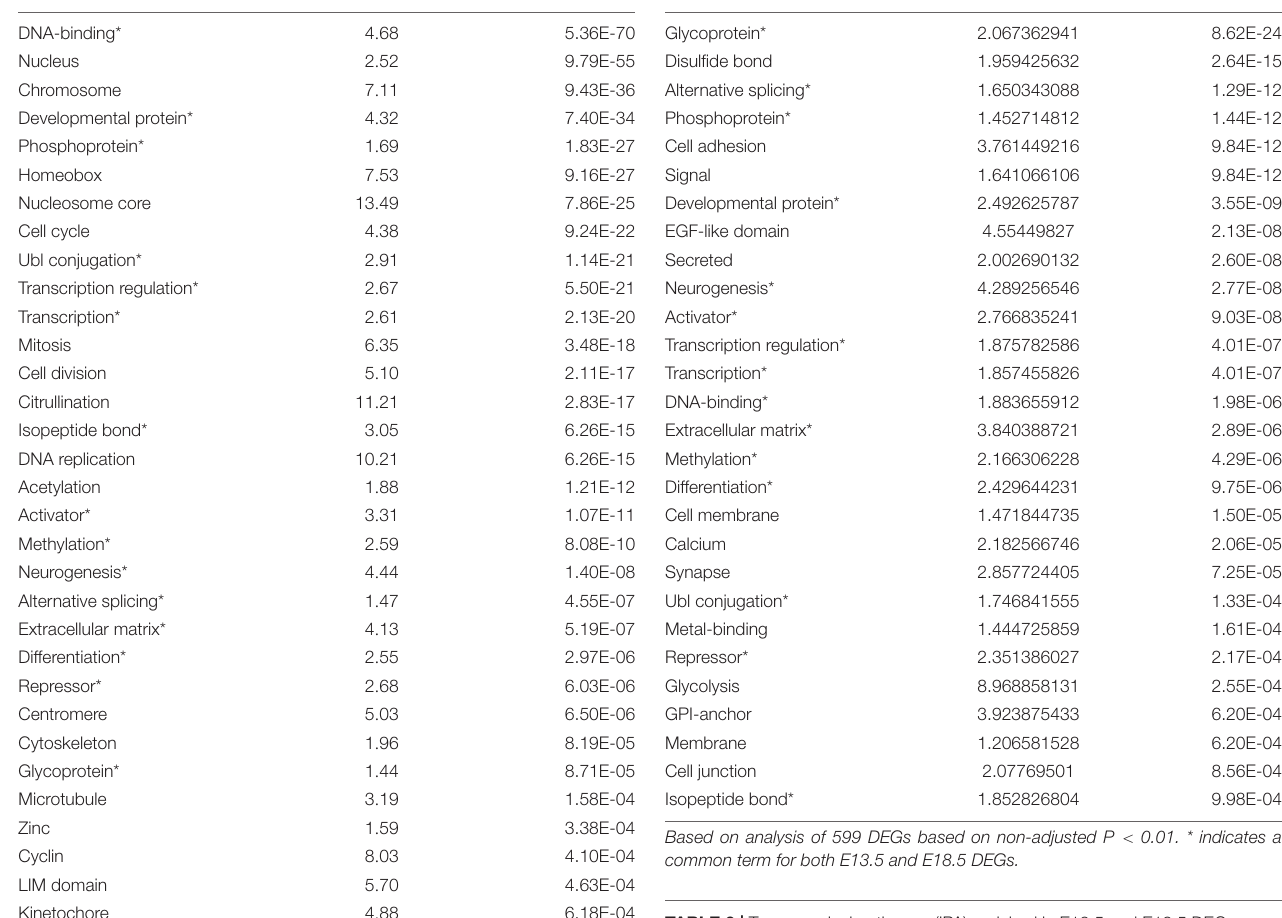
TABLE 3 | Top canonical pathways (IPA) enriched in E13.5 and E18.5